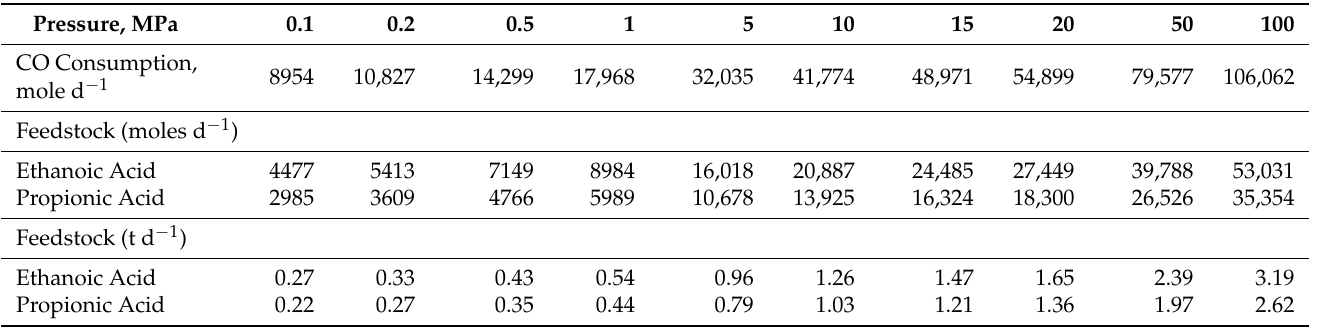
Table 23. Implied CO consumption, at = 348 K for a reactor containing 1 m 3 [CL]. Feedstock numbers assume that 100% of the CO is produced from either ethanoic acid or propionic acid. At operating pressures of >0.5 MPa, the rate constants indicate that the frequency of [CL] replacement will be increased from 6 m 3 h − 1 m − 3 reactor’s liquid